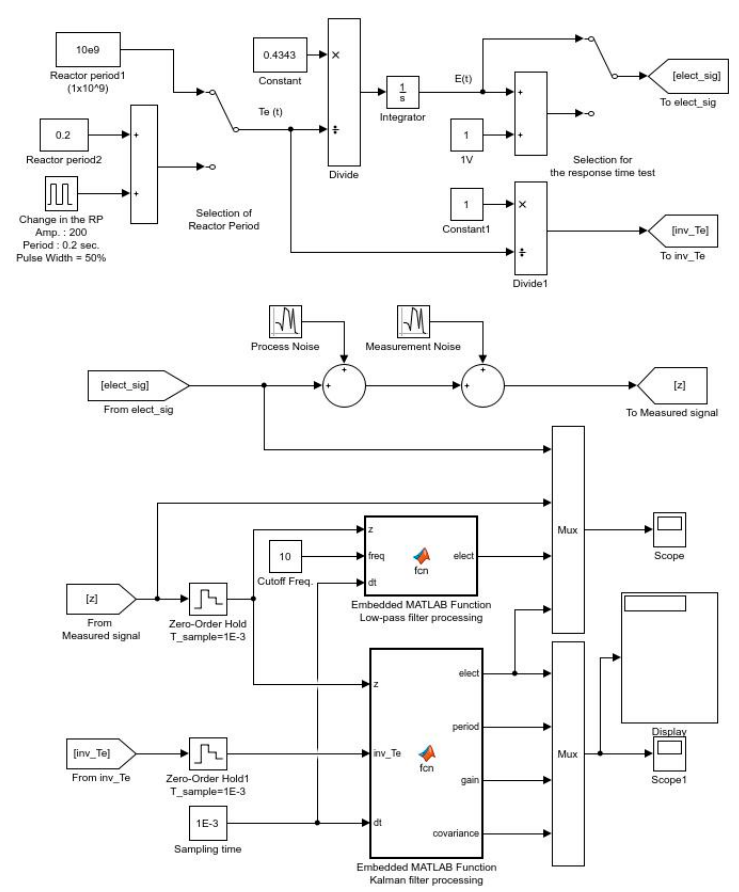
Figure 9. MATLAB Simulink model for the EKF process simulation.